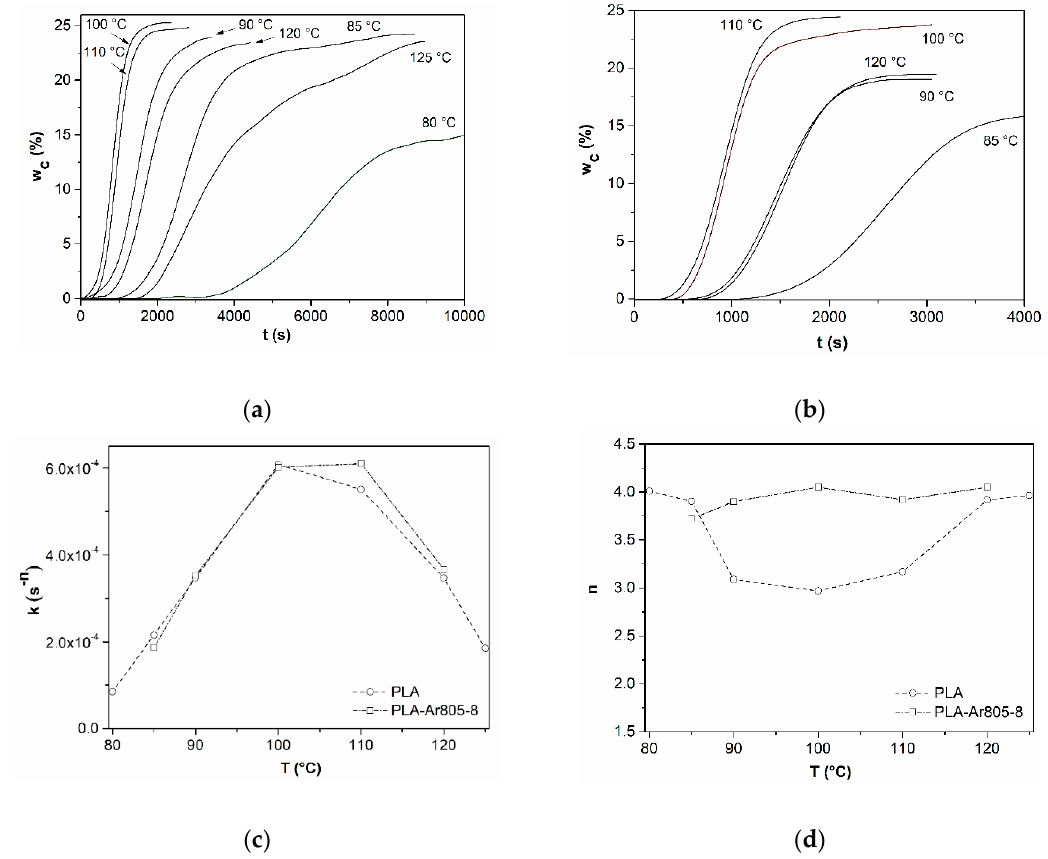
Figure 4. Crystallization kinetics of PLA and PLA-Ar805-8 nanocomposite samples. ( a ) Relative crystallinity at different temperatures of PLA; ( b ) relative crystallinity at different temperatures of PLA-Ar805-8; ( c ) k -coefficient; and ( d ) n -coefficient of the Avrami equation.